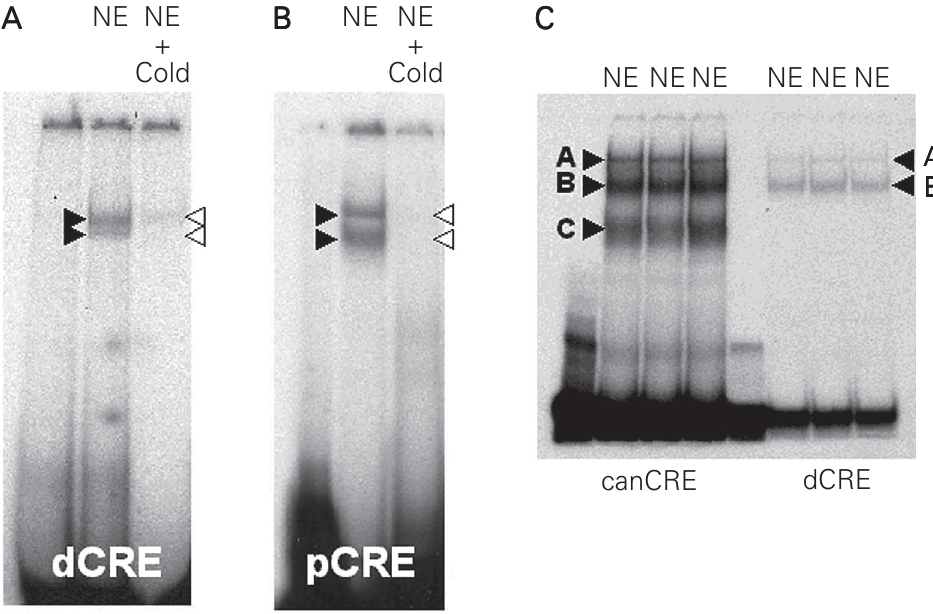
Figure 4. Gel retardation analysis of the cAMP-responsive elements pCRE and dCRE. Nuclear extracts of an endothelial cell line (REC) were combined with 32 P-labelled duplex oligonucleotides containing sequences of ACE CRE-like elements. Binding to the labeled oligonucleotide was reduced with addition of a 50-fold excess of an unlabeled duplex oligonucleotide containing the canonical CRE sequence. A , Nuclear extracts of REC produce two dCRE-retarded bands whose intensity is reduced by addition of a 50-fold excess of an unlabeled canonical CRE probe. B , Nuclear extracts of REC produce two pCRE-retarded bands that are also reduced by addition of a 50-fold molar excess of the unlabeled canonical CRE probe. C , Triplicate binding reactions for canonical CRE (canCRE) and dCRE suggest that dCRE binds with lower affinity to two out of three protein complexes binding the canonical CRE. NE = nuclear extract; Cold = 50 x unlabeled canonical CRE nucleotide. Black arrowheads indicate protein complexes (bands) binding to the labeled oligonucleotide. White arrowheads indicate bands whose intensities are reduced by excess of cold oligonucleotides (A and